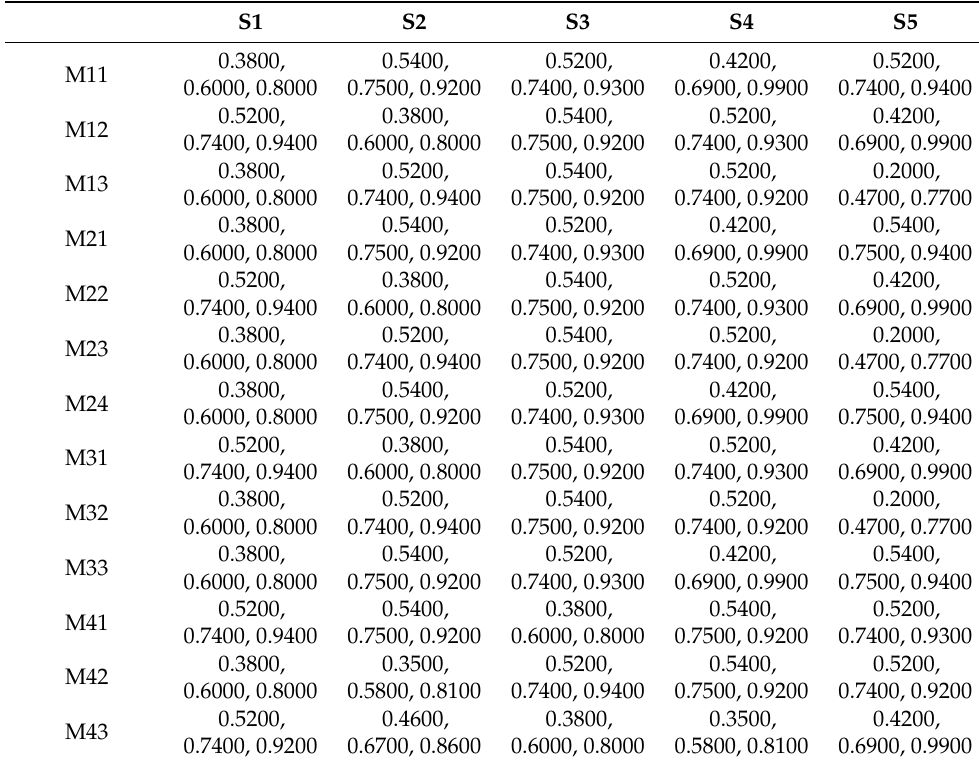
Table 16. Fuzzy decision matrix with normalized